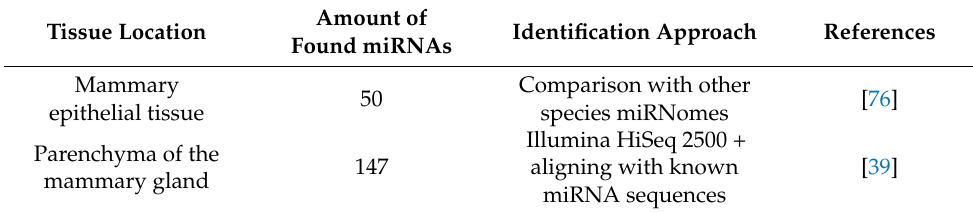
Table 3. A brief summary of all miRNAs ever found in ovine mammary